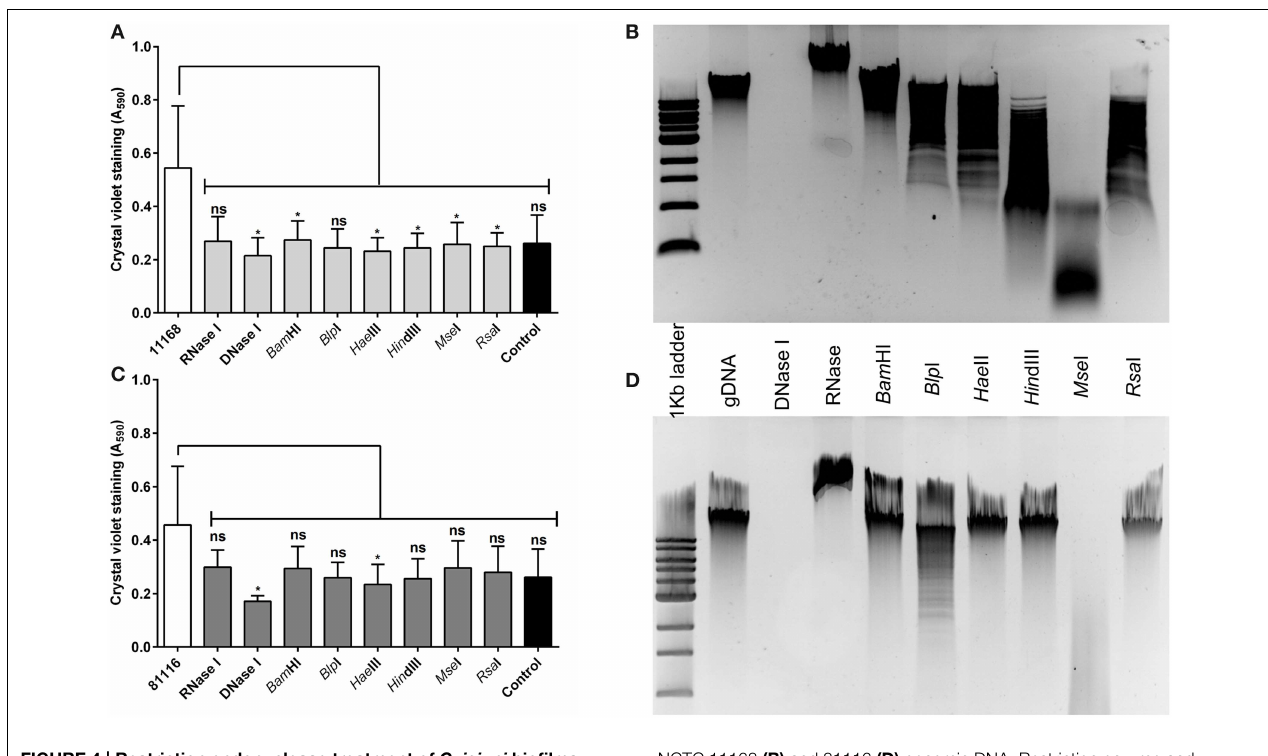
FIGURE 4 | Restriction endonuclease treatment of C. jejuni biofilms reduces biofilm formation. Static cultures of C. jejuni NCTC 11168 (A,B) and 81116 (C,D) were prepared then supplemented with either DNase I, RNase, or a single restriction endonuclease. Cultures were incubated for 48h at 37 ◦ C in aerobic conditions. A range of restriction enzymes was selected, based on varying levels of DNA fragmentation following digestion of C. jejuni